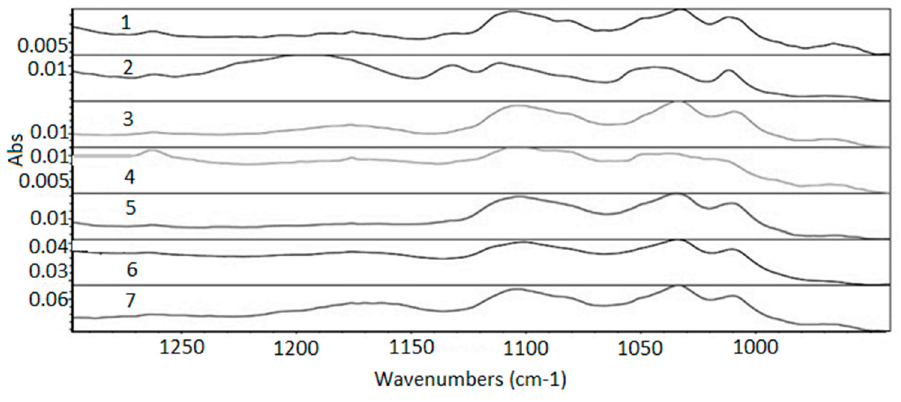
Figure 10. Absorption spectra region from 1300 to 950 cm − 1 . 1—virgin sample; 2—960 h Xenon arc sample; 3—1639 h Xenon arc sample; 4—2160 h Xenon arc sample; 5—960 h UV fluorescent sample; 6—4380 h UV fluorescent sample; and 7—8760 h UV fluorescent sample.